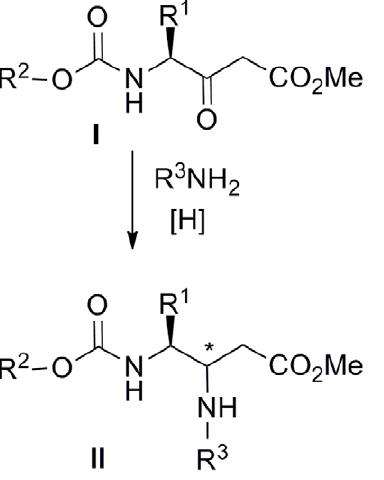
Figure 1. Intermolecular reductive amination of amino acid- derived b –ketoesters.